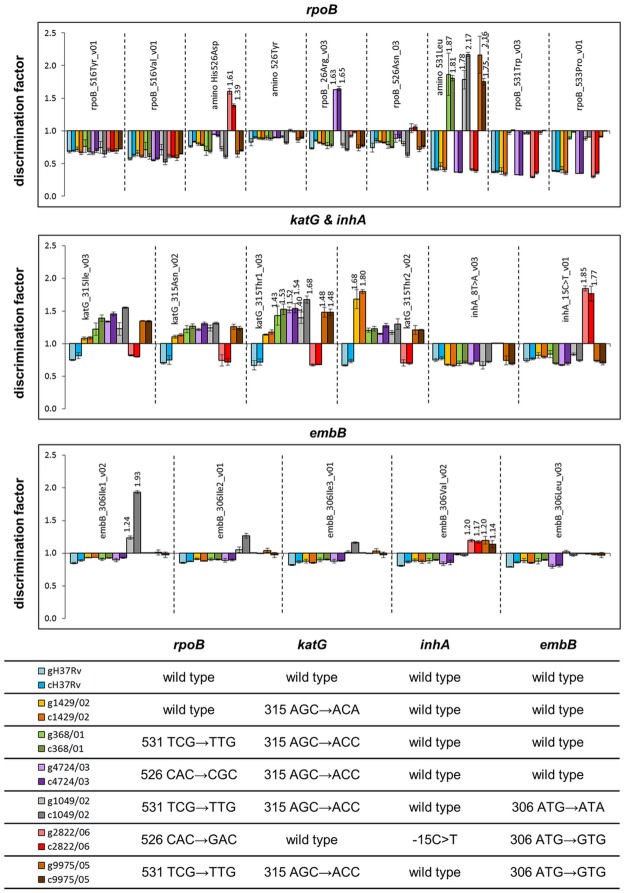
Analysis of genomic DNA (g) and heat-inactivated cell culture material (c) from different M. tuberculosis strains.The target-specific genotypes (rpoB, katG, embB, promotor region of inhA) of analyzed strains are summarized in the table below. The test results are given as discrimination factors (y-axis) and present the average of three measurements. The x-axis shows the different mutant probes in the corresponding target region. The discrimination factors are given for the reaction of a mutation on its corresponding probe. All SNPs of the particular strain isolates could be identified precisely by a discrimination factor >1 which is characteristic for a mutation and by discrimination factor < 1 at probe positions which represented the wild type. No difference in reactivity was observed when inactivated crude culture material was applied compared to genomic DNA. The test results for all strains are available in S4 Table.